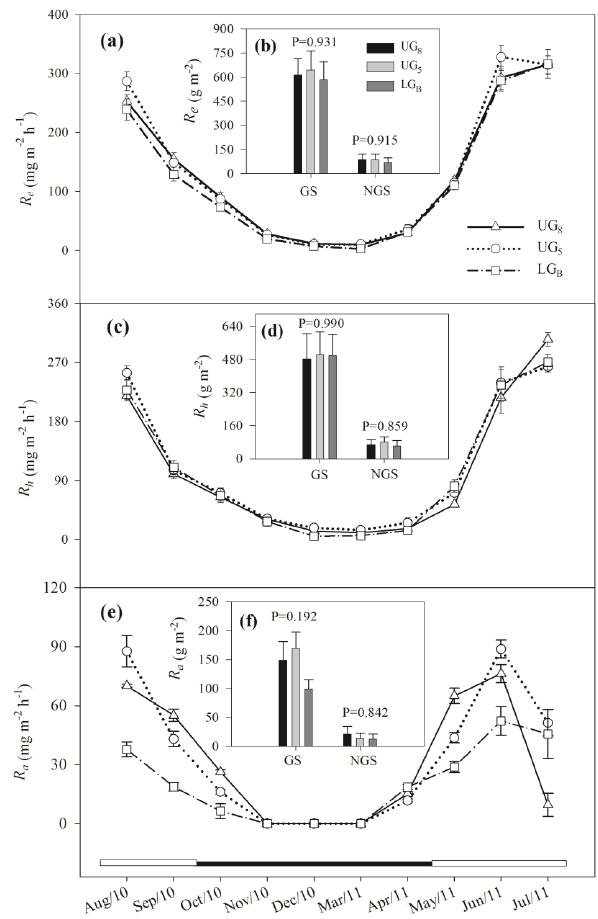
Fig. 3. CO 2 fluxes of ecosystem respiration ( R e ) , heterotrophic respiration ( R h ) and autotrophic respiration ( R a ) at sites UG 8 (ungrazed since 2003), UG 5 (ungrazed since 2005) and LG B (grazed all year) within (GS) and outside (NGS) the growing season respectively using a Li-8100. White and black horizontal bars represent within (GS, 2010 and 2011) and outside (NGS) the growing season, respectively.